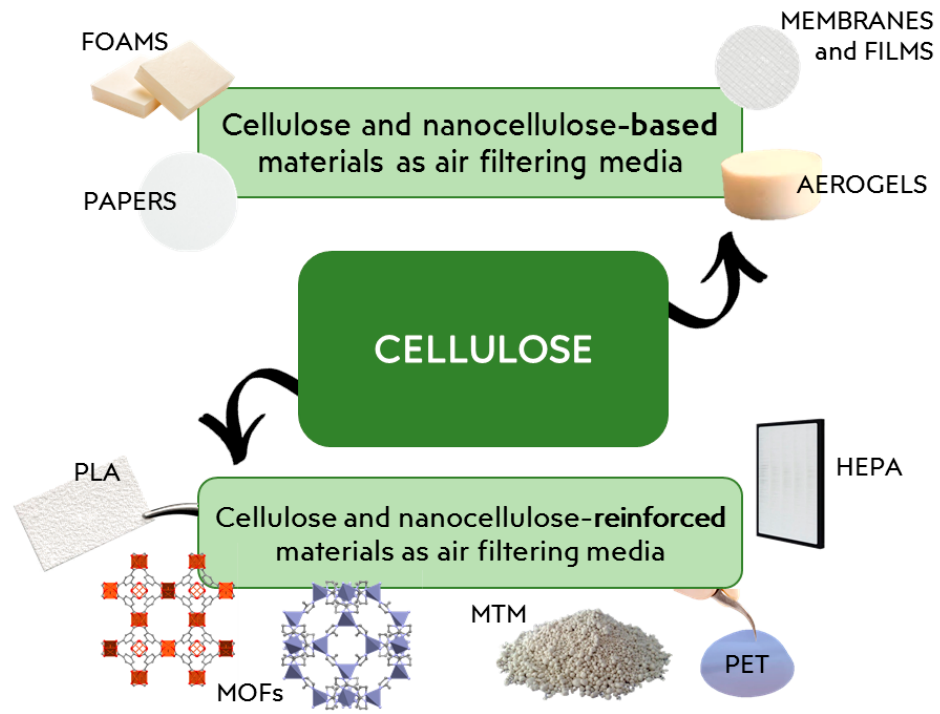
Figure 3. Different filtering systems obtainable from cellulose, discussed in detail in Sections 3.1